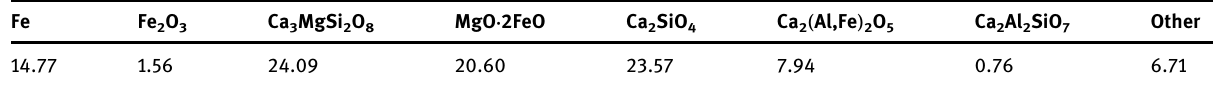
Table 3: Phase composition of Steelmaking slag of Baogang Steel wt% Fe Fe 2 O 3